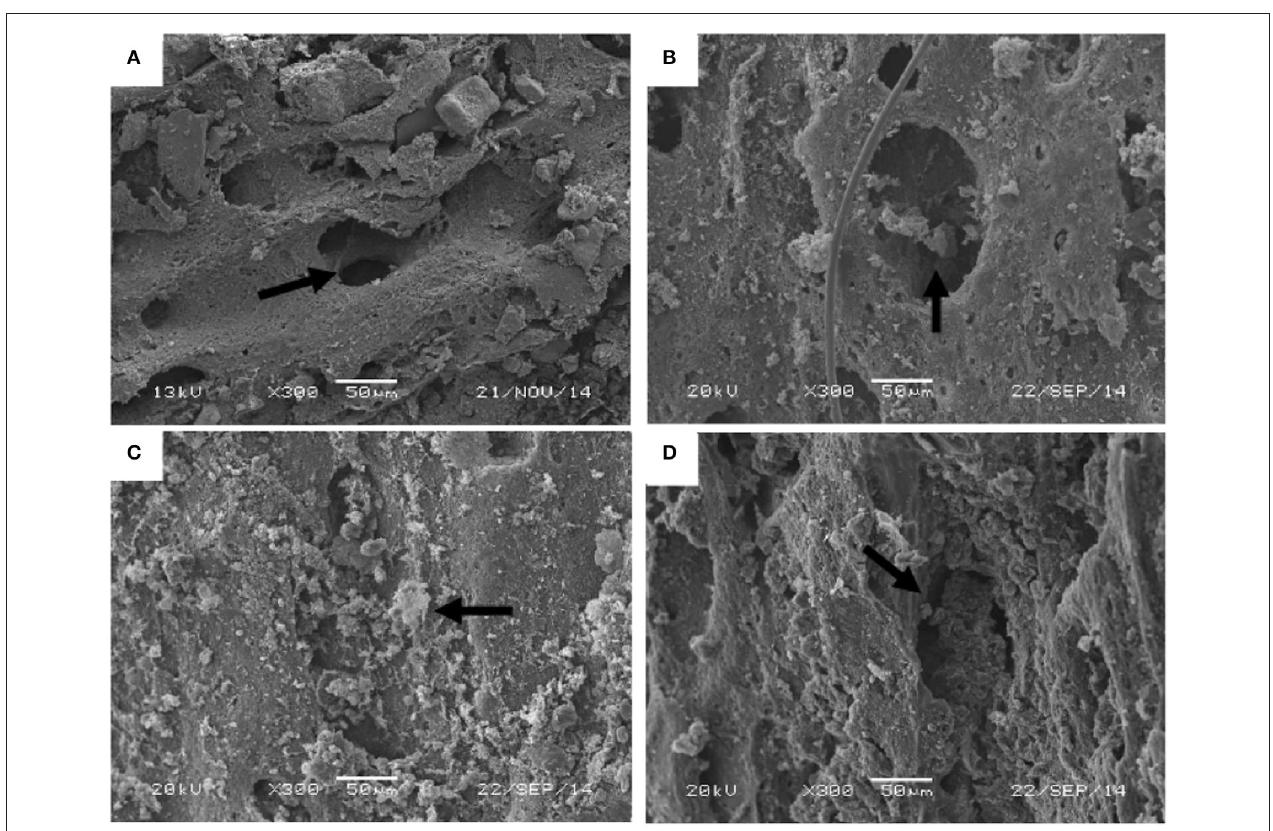
FIGURE 4 | Examples of Vector Infiltration Classes for statistical analysis: (A) Class 0—no biofilm visible inside of canal. Arrow indicating the biofilm-free canal wall; (B) Class 1—some biofilm coating inner pore wall. Arrow indicating the presence of early-stage biofilm development; (C) Class 2—biofilm thickening and beginning to seal pore aperture of a whole femur. Arrow indicating the increasing abundance of biofilm; (D) Class 3—near complete infilling of the canal. Arrow indicating the presence of nearly complete covering of biofilms. All images are SEI, taken under HV71 at 300x magnification, 40 spotsize, with a 20 keV accelerating voltage and a working distance of 8–12 mm.